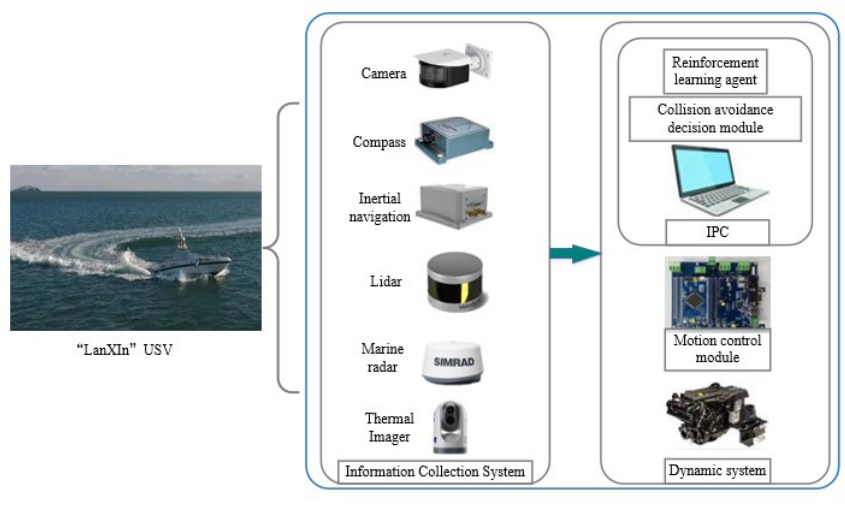
Figure 4. “Lanxin” USV perception system experimental